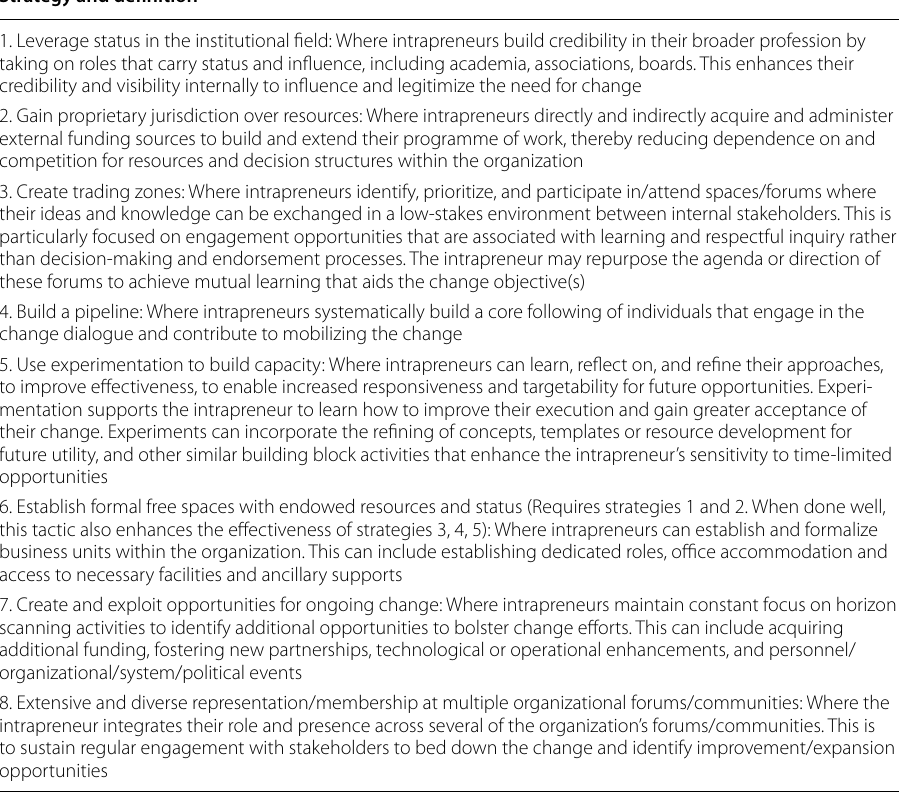
Copyright INFORMS, Institute for Operations Research and Management of Science